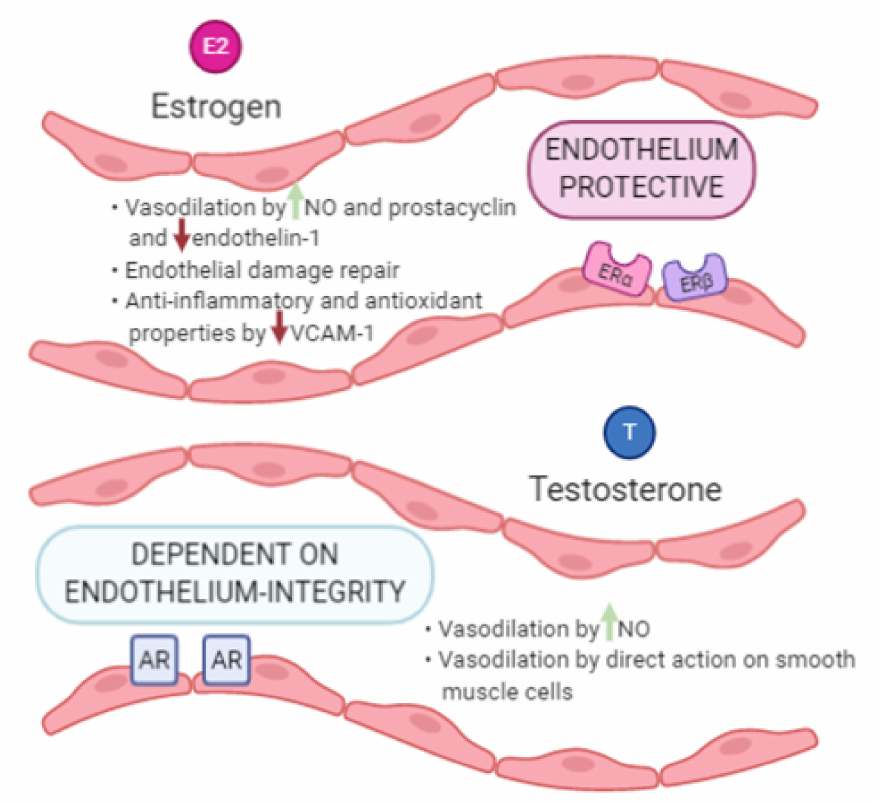
Figure 1. A graphical representation of the synthesis of the estrogens and testosterone actions at endothelial level. Footnote to Figure 1: AR: androgen receptor; ER: estrogen receptor; NO: nitric oxide; VCAM: vascular cell adhesion